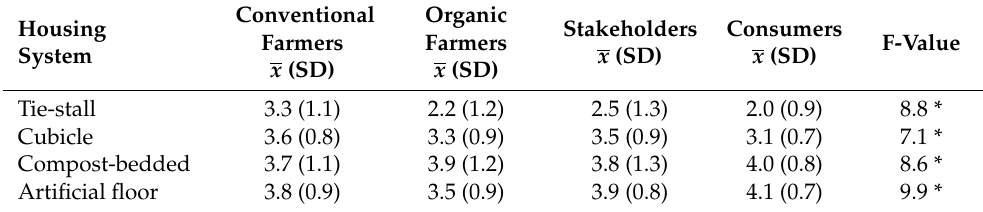
Table 2. Mean scores and standard deviations of housing systems’ acceptability per respondent category.